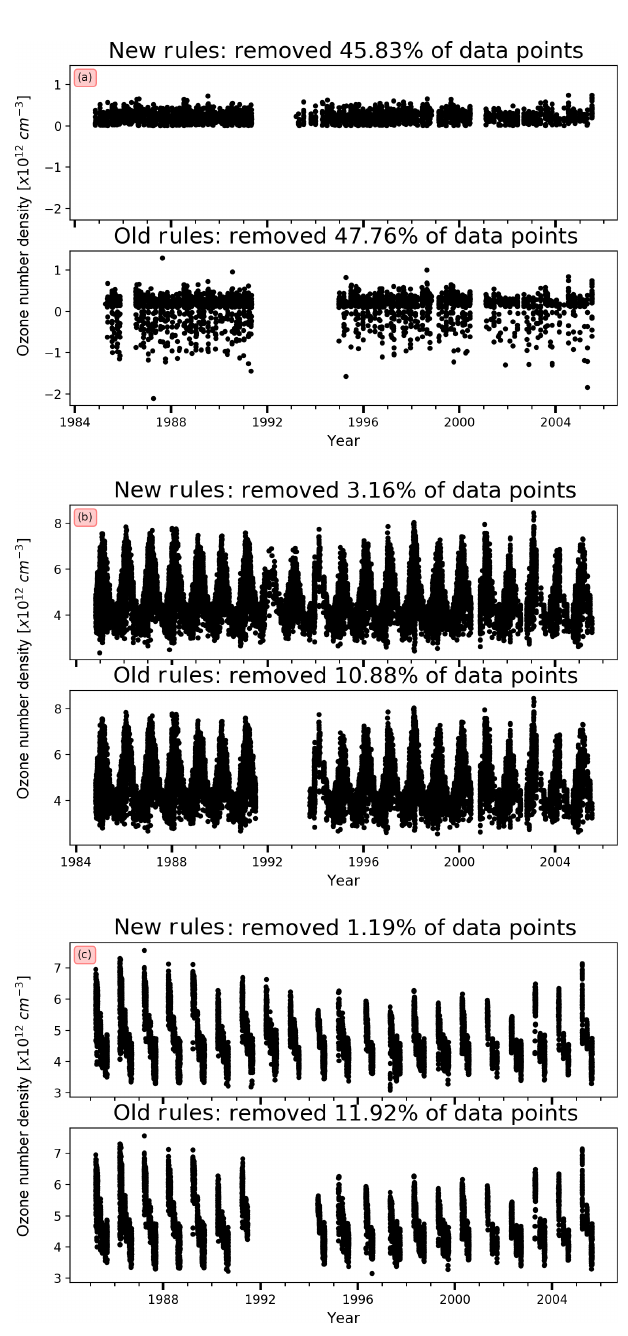
Figure 14. SAGE II ozone at (a) 16km between 5 ◦ S and 5 ◦ N, (b) 20km between 45 and 55 ◦ N, and (c) 20.5km between 65 and 75 ◦ N. SAGE II data shown represent the remaining ozone data after the new (top) and current (bottom) rules were